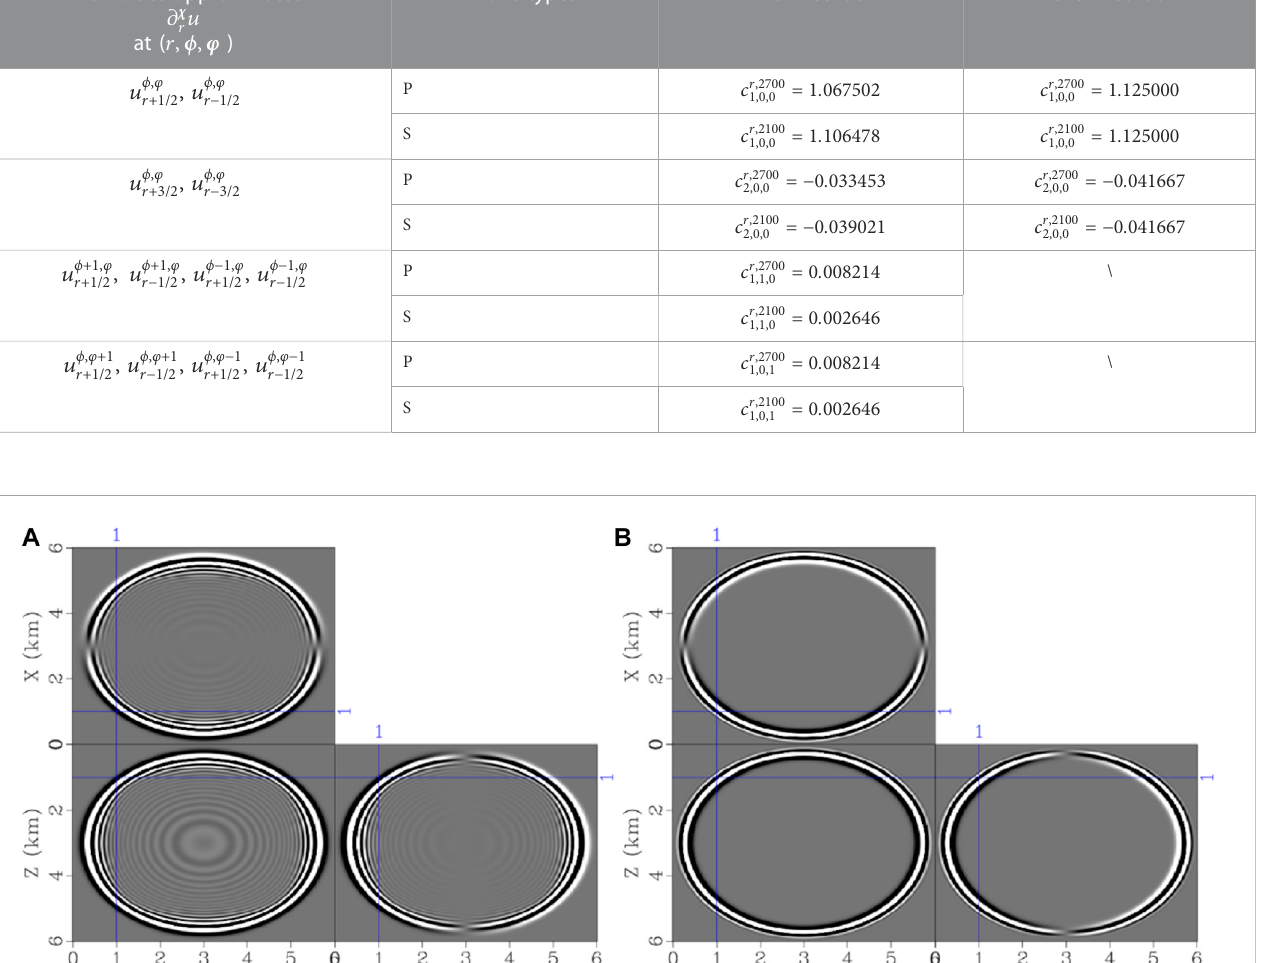
TABLE 1 Staggered-grid fi nite-difference (SGFD) coef fi cient comparison between the STS and FTS methods using the same fourth-order spatial SGFD accuracy. The velocities are 3700 and 2100 m/s for P and S waves, respectively, the grid interval is 20 m, and the time step is 2.4 ms. Grid values approximated z χ